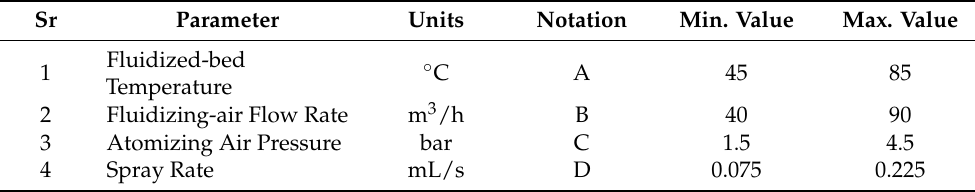
Table 2. Trial runs’ maxima and minima of the studied process